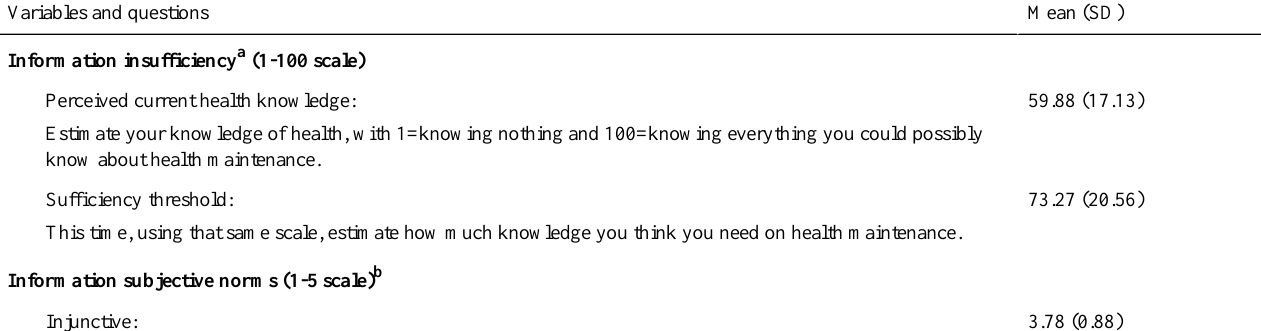
Table 2. Descriptive statistics of RISP predictor variables